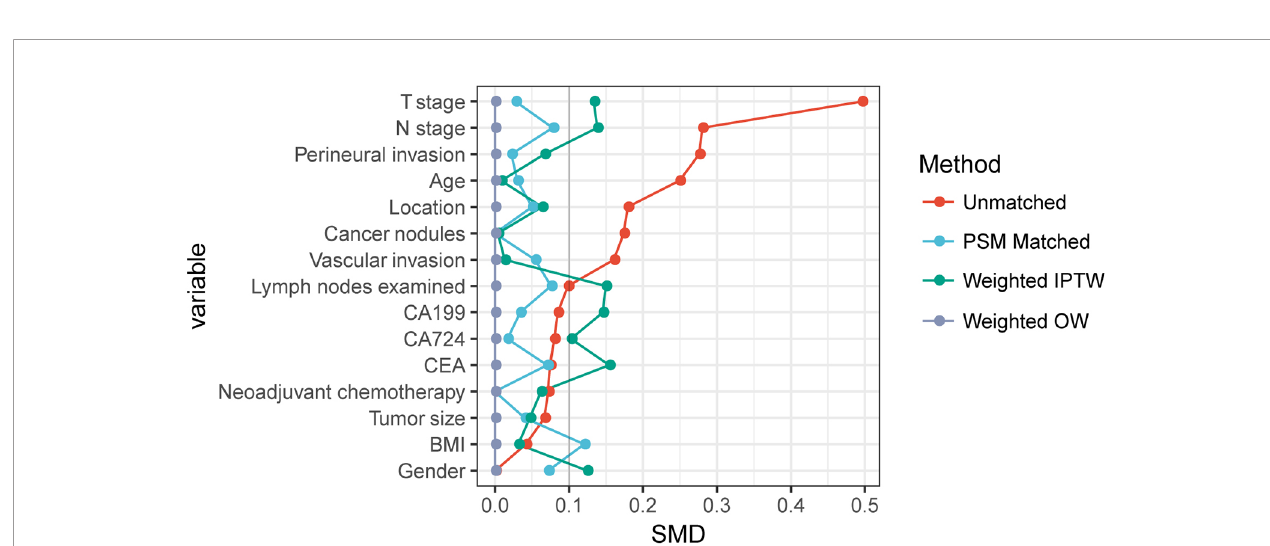
FIGURE 3 | Comparability of baseline characteristics based on standardized mean difference in different survival analysis method.